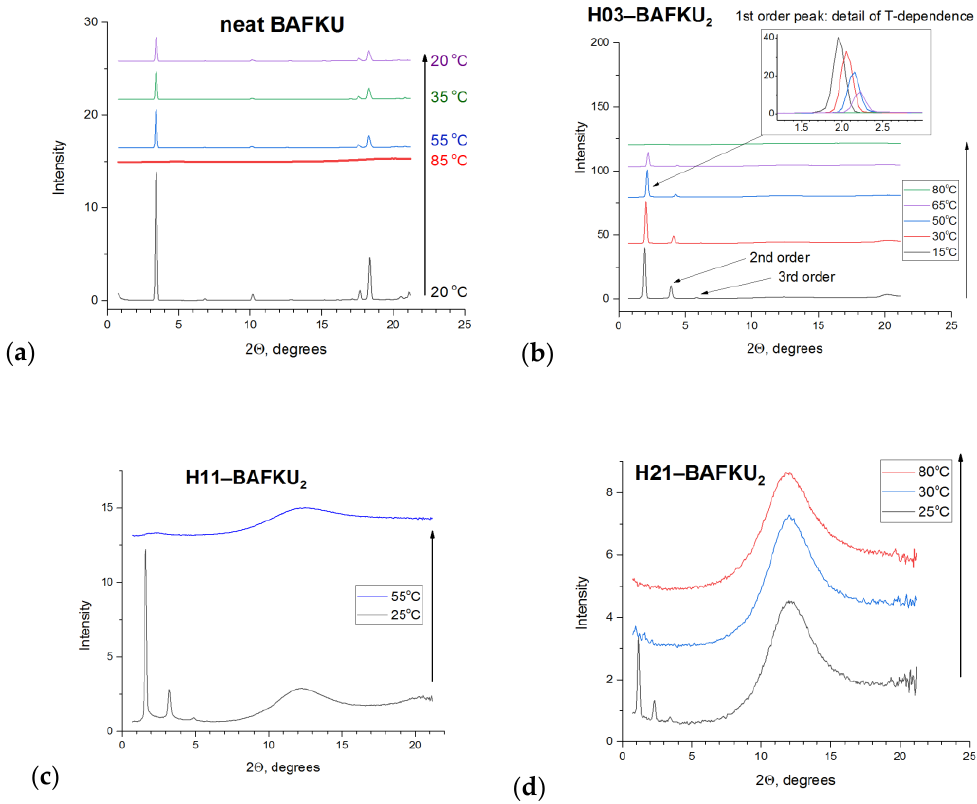
Figure 4. Temperature-dependent XRD patterns of: ( a ) neat BAFKU, ( b ) H03–BAFKU 2 , ( c ) H11–BAFKU 2 , and ( d ) H21–BAFKU 2 ; in the case of neat BAFKU ( a ), the sample was first characterized at 20 °C, then heated up to 85 °C, and subsequently, step-wise cooled down back to 20 °C. This was done because the full series of phase transitions in BAFKU occurs only in the cooling scan; in the case of all the copolymer samples ( b – d ), they were step-wise heated from low temperature to high temperature during the XRD analyses. Table 2. X-ray di ff raction results. BAFKU: interference maxima and the corresponding characteristic